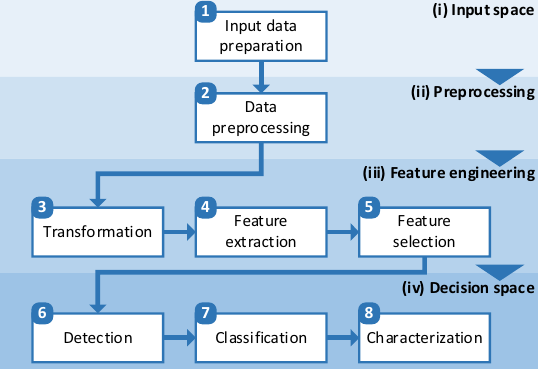
Fig. 7 General scheme for real‑time detection and classification of PQDs and transversal topics to be dealt with in the